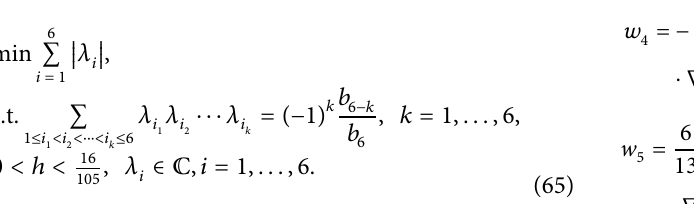
, (b) Errors 𝑘 󵄩󵄩󵄩󵄩𝐸(𝑡 𝑘 )󵄩󵄩󵄩󵄩